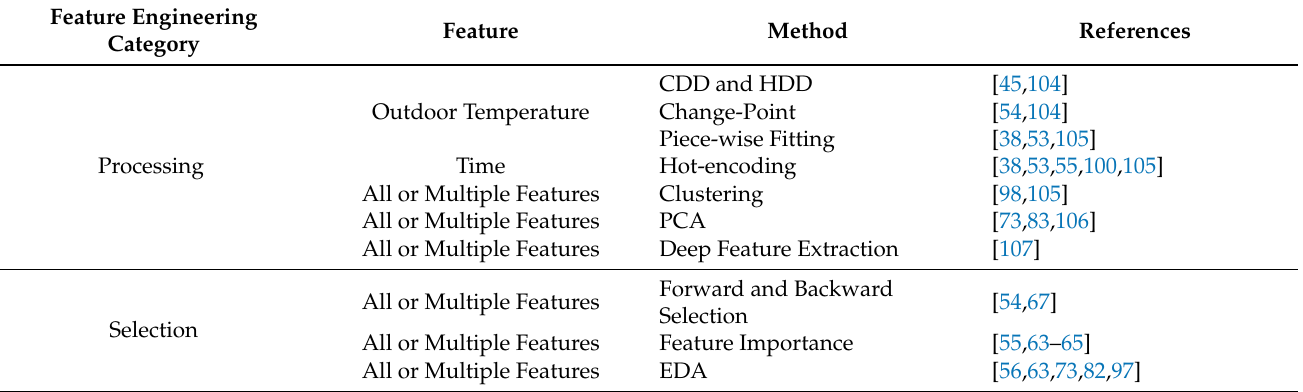
Table 8. Feature engineering methods in building energy consumption